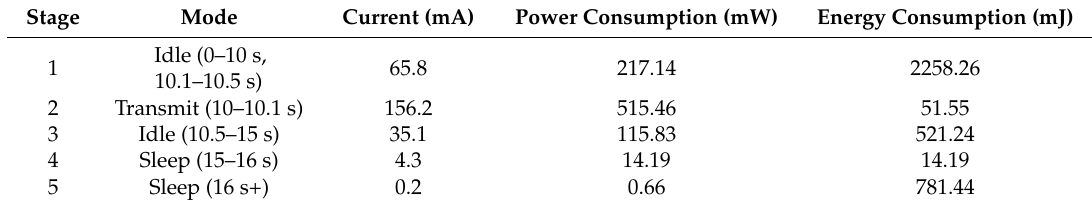
Figure 4. ( a ) Current waveform from DC power supply; ( b ) zoom-in of stage 2; ( c ) current waveform from battery power; ( d ) current waveform from supercapacitor. Table 2. Power consumption for sensor node device (actual measurements using